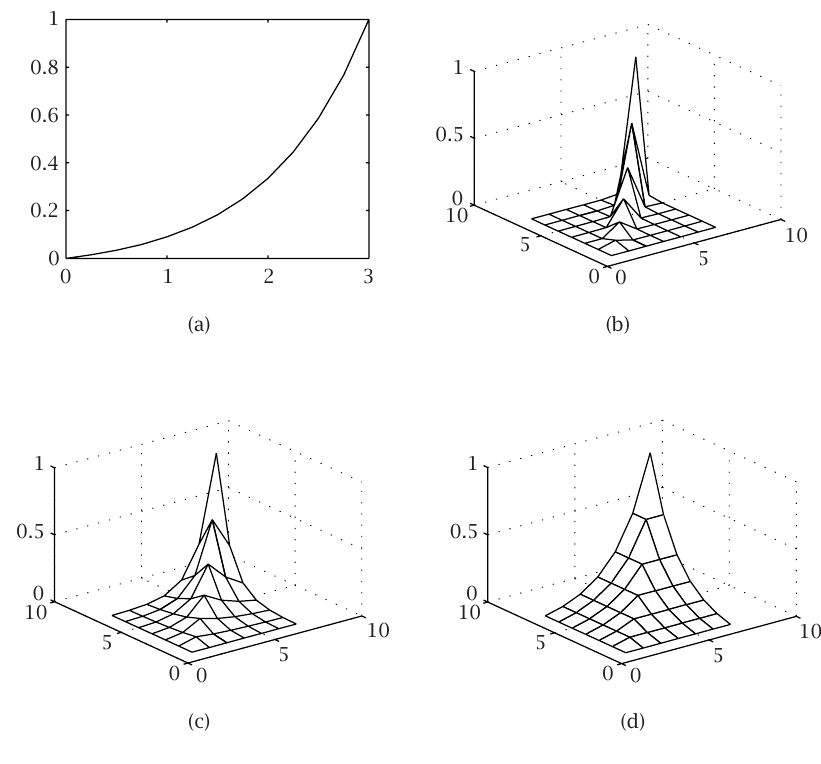
≤ x ≤ 3, plotted in (a) and Figure 3.1 . Covariance kernels, with R i (x,x) , 0 (b), (c), and (d) represent various versions of possible kernels. For clarity, the x and y axes are labeled 0 , 1 ,..., 7 for the partition x j = y j = 3 j/